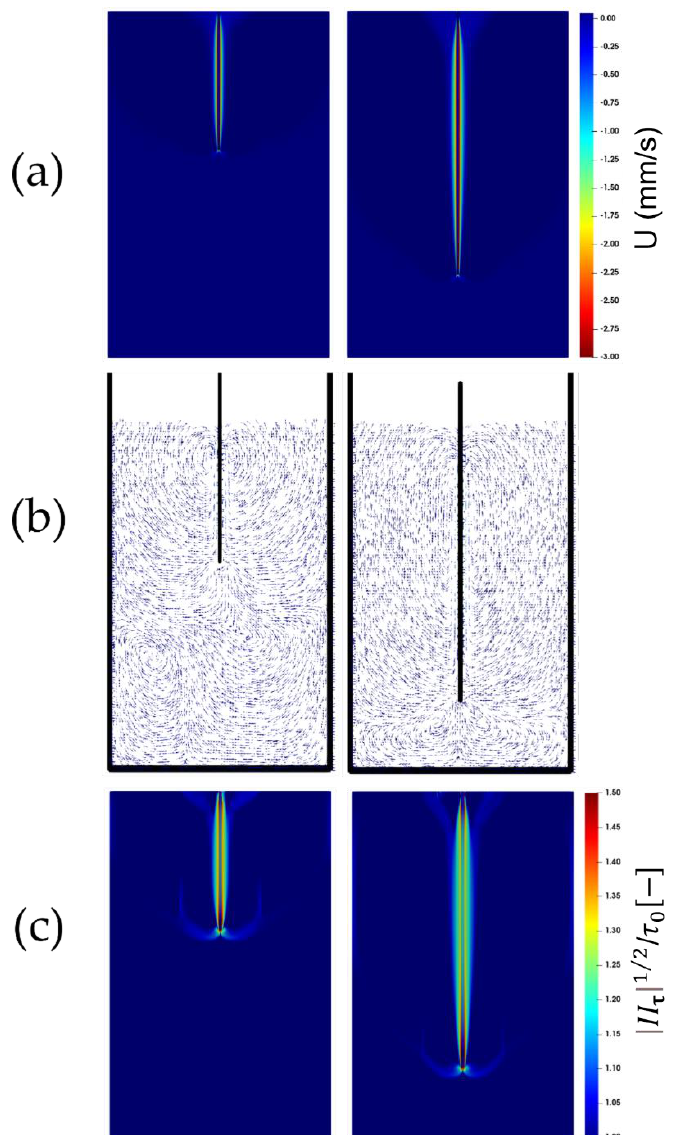
Figure 4. Snapshots of the flow for the plate immersion velocity of 3 mm/s. The top contour plots are ( a ) the fluid velocity, and ( c ) the bottom contours are the square root of the second invariant of the viscous stress tensor compared to the yield stress τ 0 . The middle vector ( b ) fields show the velocity vectors within the domain.